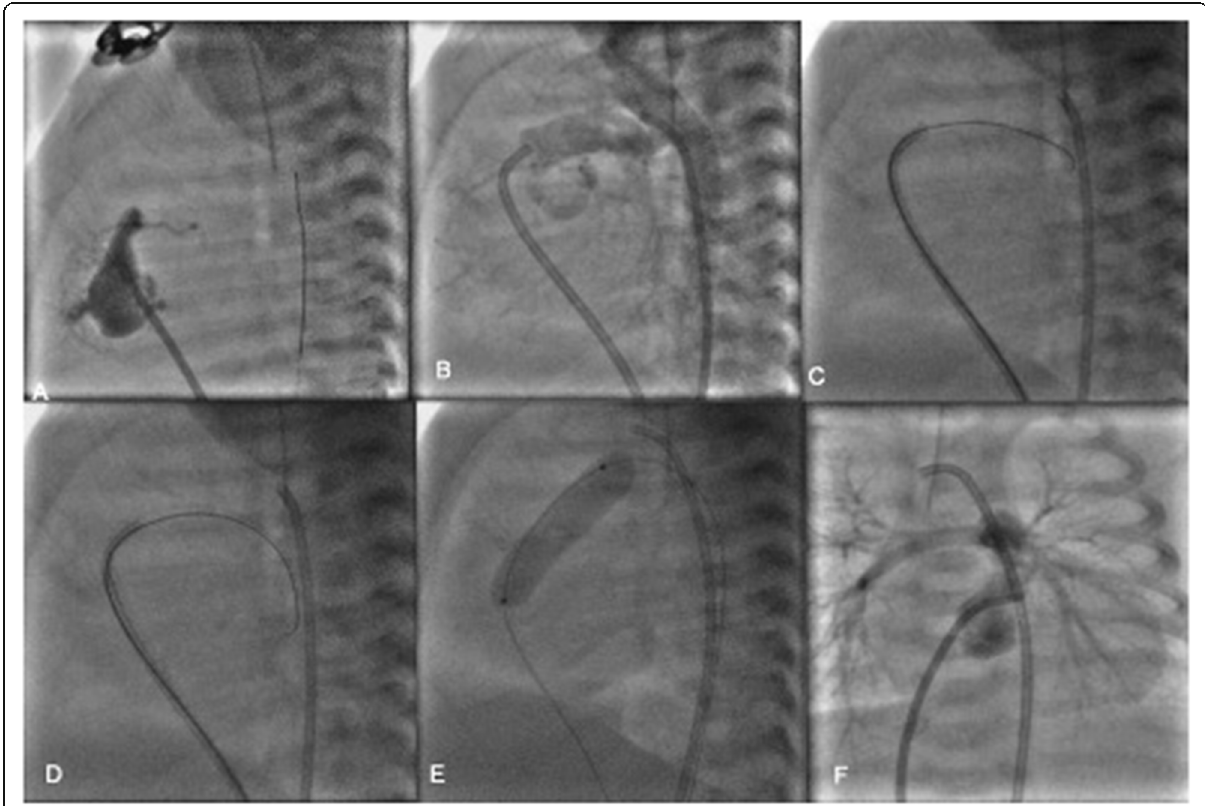
Fig. 2 a JR guide at the atretic RVOT, with contrast filling of the RV and ending as bling pouch. b Injection in the arch of the aorta showing filling of the PA branches through PDA and also confirming guide position at the RVOT. c RVOT perforation with coronary guidewire. d Successful crossing of the guidewire across the atretic RVOT after perforation and wire parked in the DTA E Serial Balloon dilatation of the RVOT. f Final angiogram showing good antegrade pulmonary blood flow and